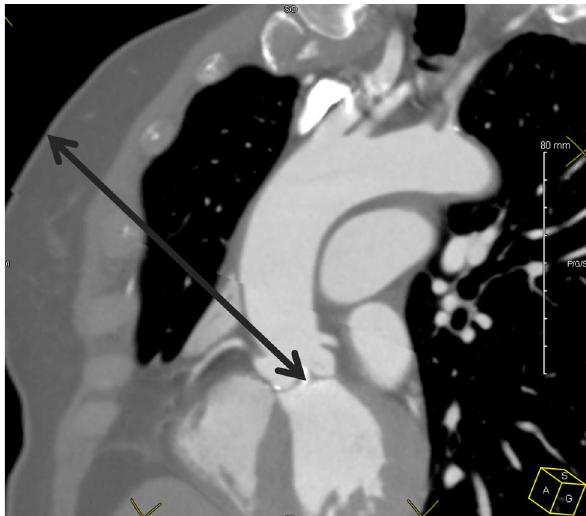
Figure 2. Skin Aortic Ring Center Distance (SARCD)